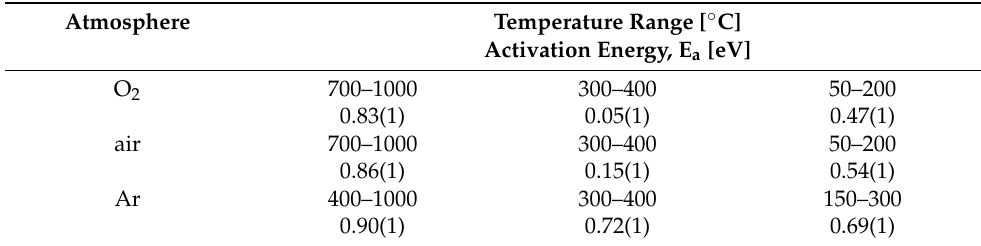
Table 3. Activation energy of the electrical conductivity evaluated for Pr005 sample in O 2 , air, and in Ar.